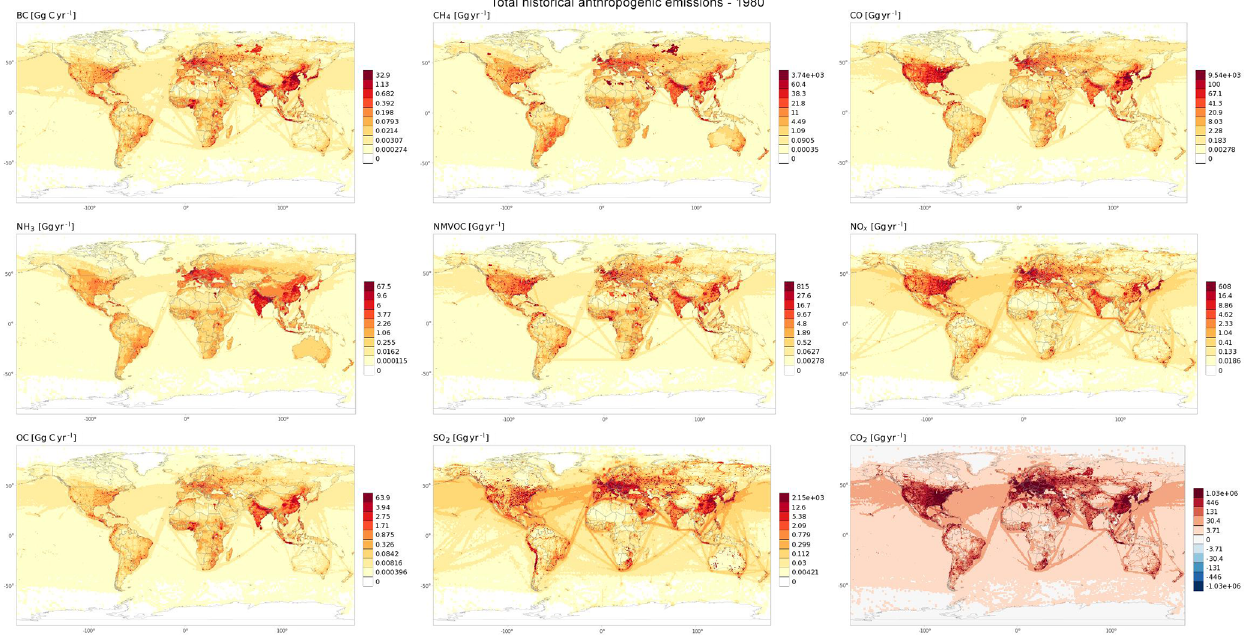
Figure 5. Total anthropogenic emissions in 1980 by species. The color scale is the same for each emission species across all gridded figures for comparison. Note that the CO 2 color scale accommodates the net negative emissions found in some future scenarios.